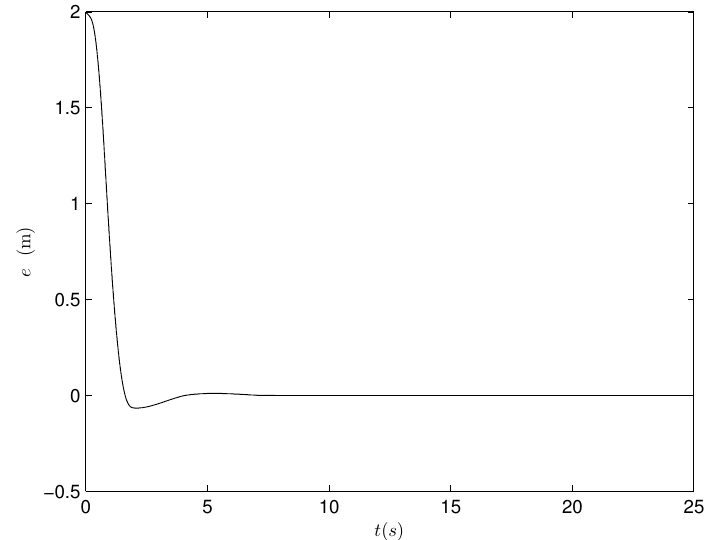
Figure 3. Surge tracking error (output feedback barrier adaptive